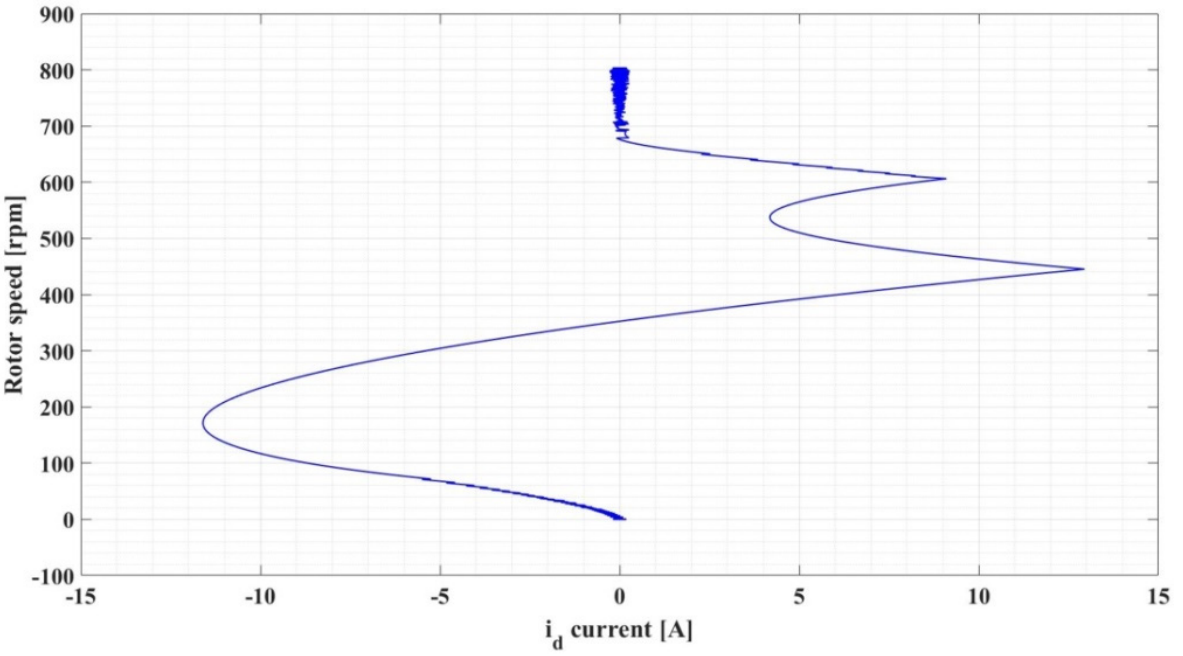
Figure 27. Image of the phase plan for PMSM variable structure with switching signal type 2: i q current versus i d current ( ω ref = [800, 1200] rpm).